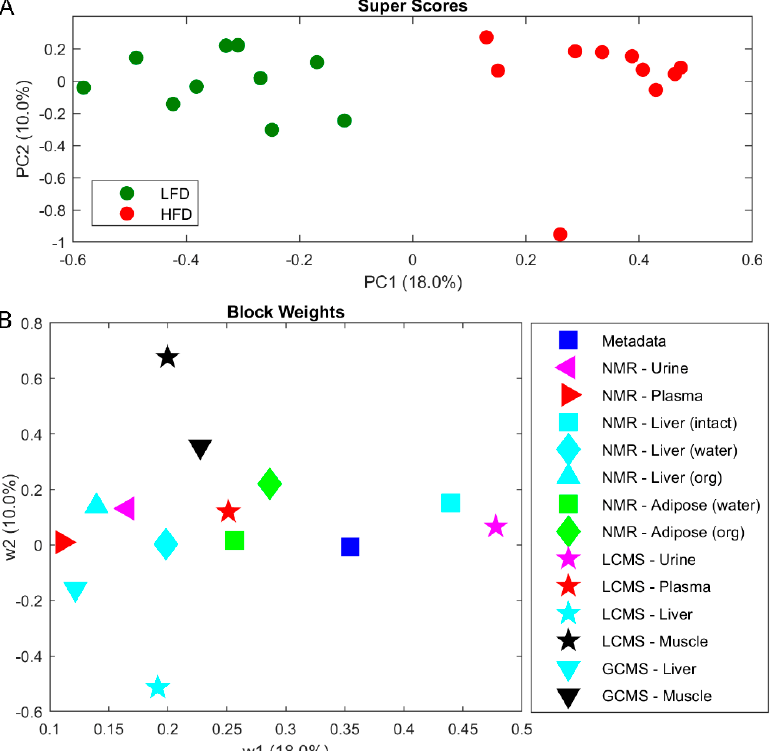
Figure 3. Multi-block principal component analysis (PCA) on metabolomics data from biofluids and tissues as indicated. ( A ) Super scores scatter plot. ( B ) Block weights of biofluids and tissues. Abbreviations: LFD, low ‐ fat diet; HFD, High ‐ fat diet.